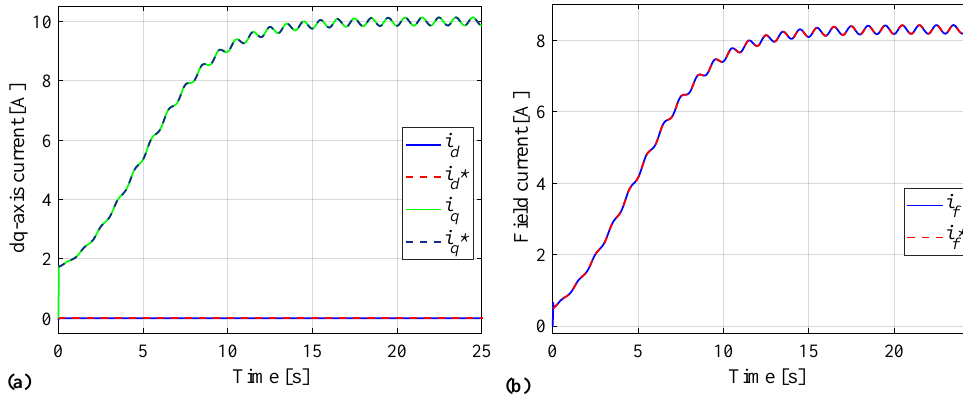
Figure 17. ( a ) dq -axis and ( b ) field currents for wind speed input of 1 Hz versus time.